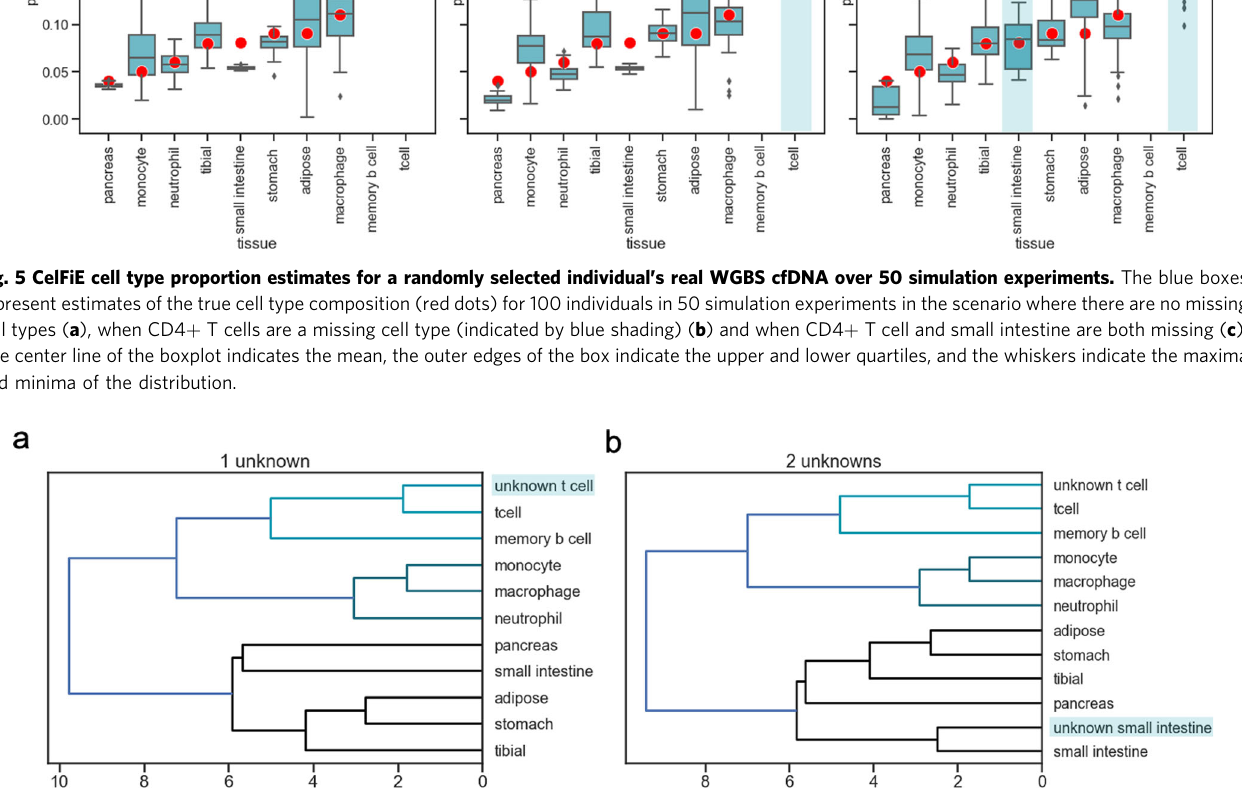
Fig. 6 Hierarchical clustering of the CelFiE methylation proportion estimates for (a) one unknown and (b) 2 unknowns with the true WGBS methylation proportions. The shaded blue box indicates the unknown tissue. The light blue, dark blue, and black colors indicate clusters of tissues detected by the hierarchical clustering